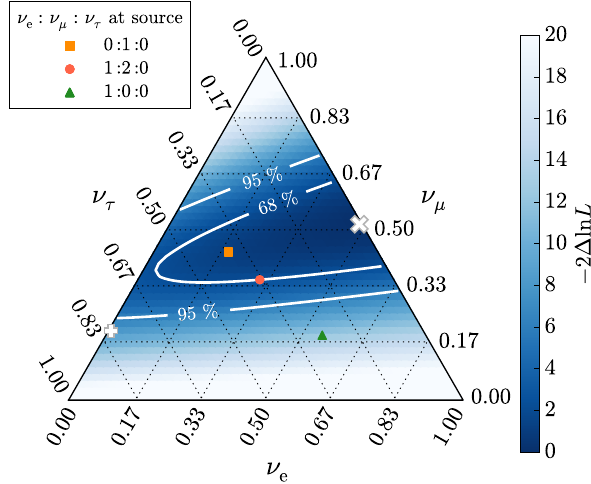
Fig. 8 Observed flavour composition of astrophysical neutrino with IceCube [81]. The best-fit flavour ratio is indicated by a white “ × ”, with 68% and 96% confidence levels indicated by white lines. The expected oscillation-averaged composition is indicated for three differ- ent initial compositions, corresponding to standard pion decay (1:2:0), muon-damped pion decay (0:1:0), and neutron decay (1:0:0). The white “ + ” indicate the best-fit from a previous analysis [39]. From Ref.